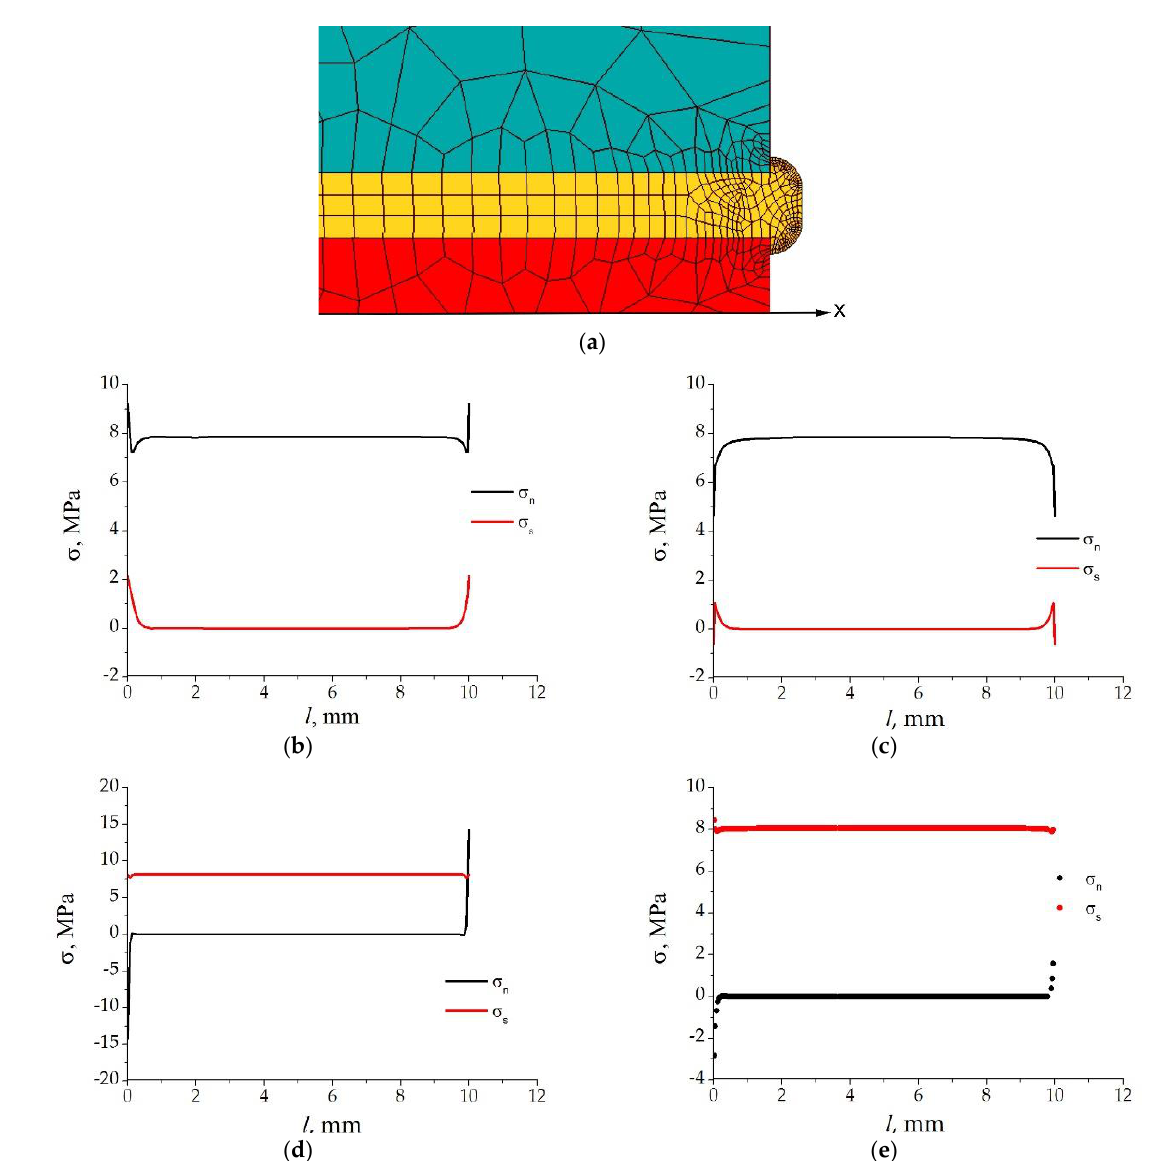
Figure 2. A fragment of the finite element mesh of the edge region of the Arcan specimen ( a ); the diagrams of normal and shear contact stresses for the specimen with a flat-edged adhesive layer ( b , d ) and that with a ridge-shaped lateral surface of the adhesive layer ( c , e ) in cleavage ( b , c ) and shear ( d , e ) testing.